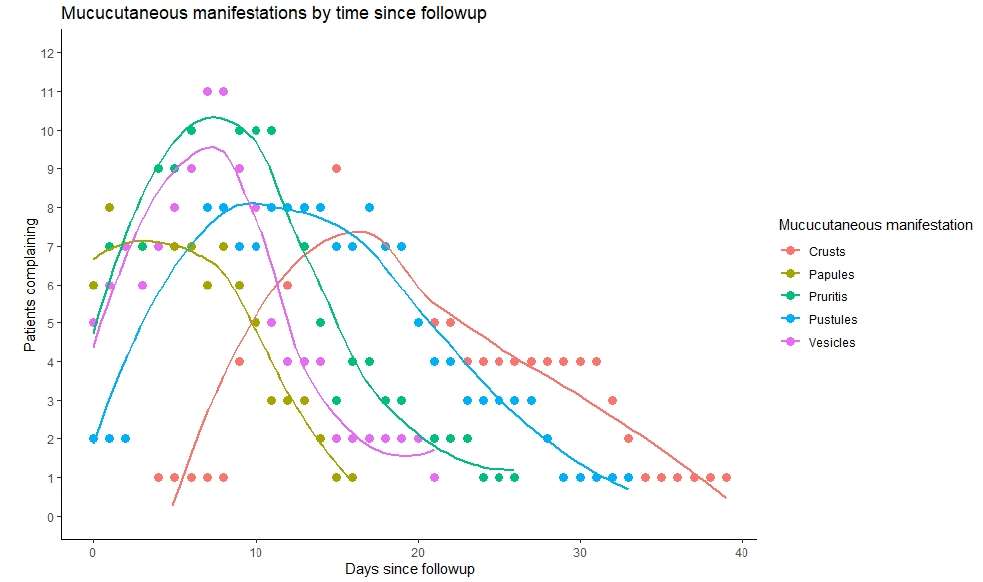
Figure 5. Morphological evolution of mucocutaneus lesions by days since infection (x axis), relative to the number of patients who reported them on that day (y